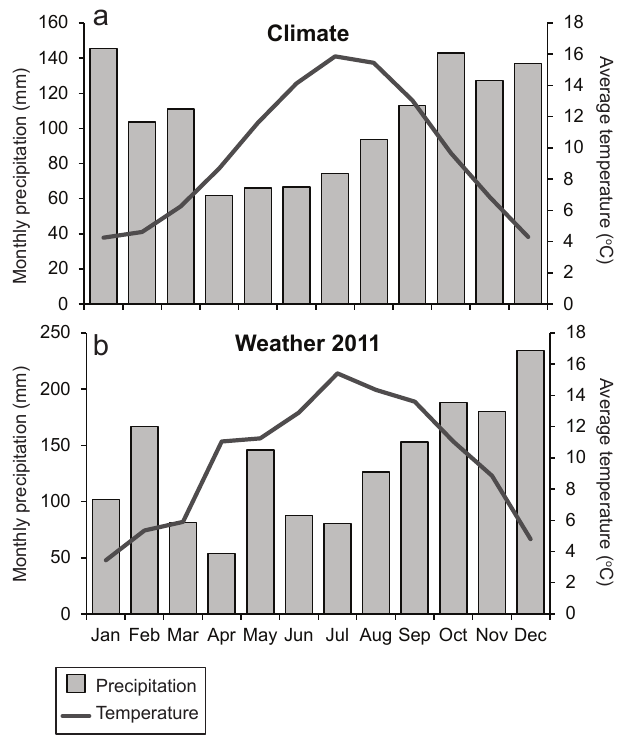
Figure 2. (a) Average monthly temperatures and precipitation for the years 1980–2010 and (b) mean monthly temperatures and pre- cipitation for the year of SPM sampling, 2011, all recorded at the Paisley weather station, ca. 40km from Loch Lomond and at a 32m elevation. All data are courtesy of the UK Met Office (http: